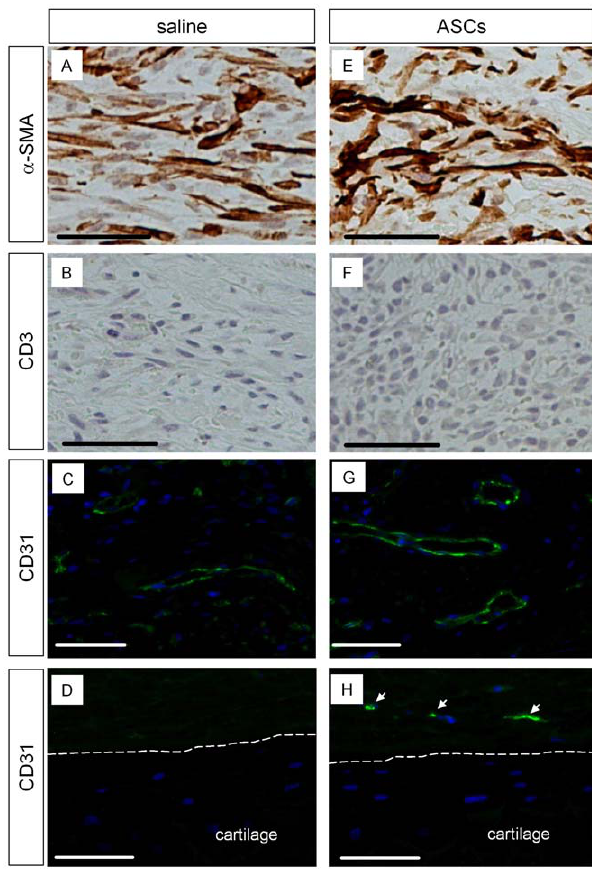
Figure 6. Analysis of protein expression in ASCs treated wounds. Saline control (A, B, C, D) and ASCs (E, F, G, H) were delivered to wounds and harvested as described in Figure 3. a -SMA (A, E) and CD3 (B, F) were visualized by DAB after staining with their specific antibodies. CD31 (C, D, G, H) was stained with its specific antibody and visualized using fluorescence conjugated secondary antibody. (A, B, C, E, F, G): images were taken from the area labeled as ‘a’ in Figure 4. (D, H): Immunostaining for CD31 in the area labeled as ‘b’ in Figure 4. The junction area between cartilage and wound beds was demarcated by white dot lines. CD31 positive signals were indicated by arrows in H. Scale bars: 50 m m.